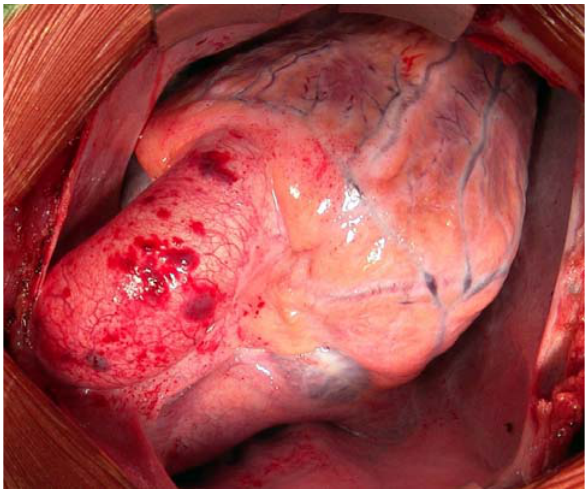
Fig.4 – Imagem da aorta anterior e tronco pulmonar